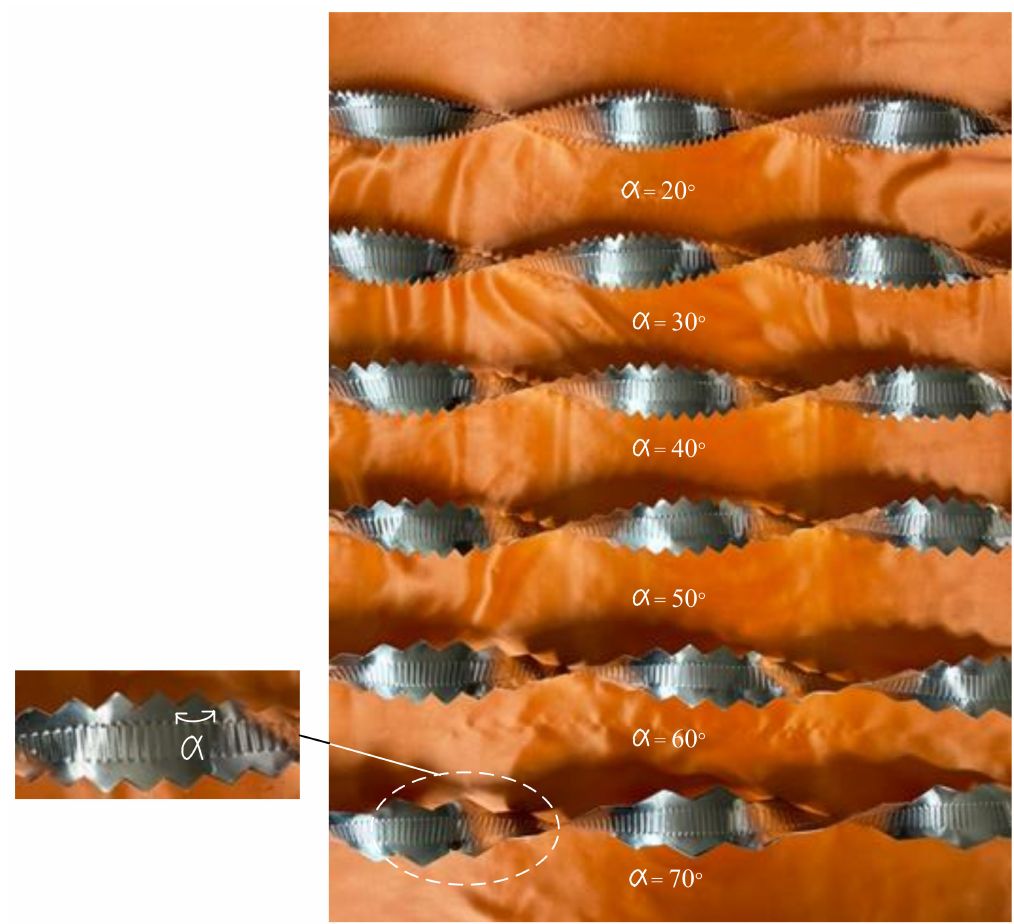
Figure 2. Images of twisted tapes in rib and sawtooth form (TTRS) with α = 20 ◦ , 30 ◦ , 40 ◦ , 50 ◦ , 60 ◦ , and 70 ◦